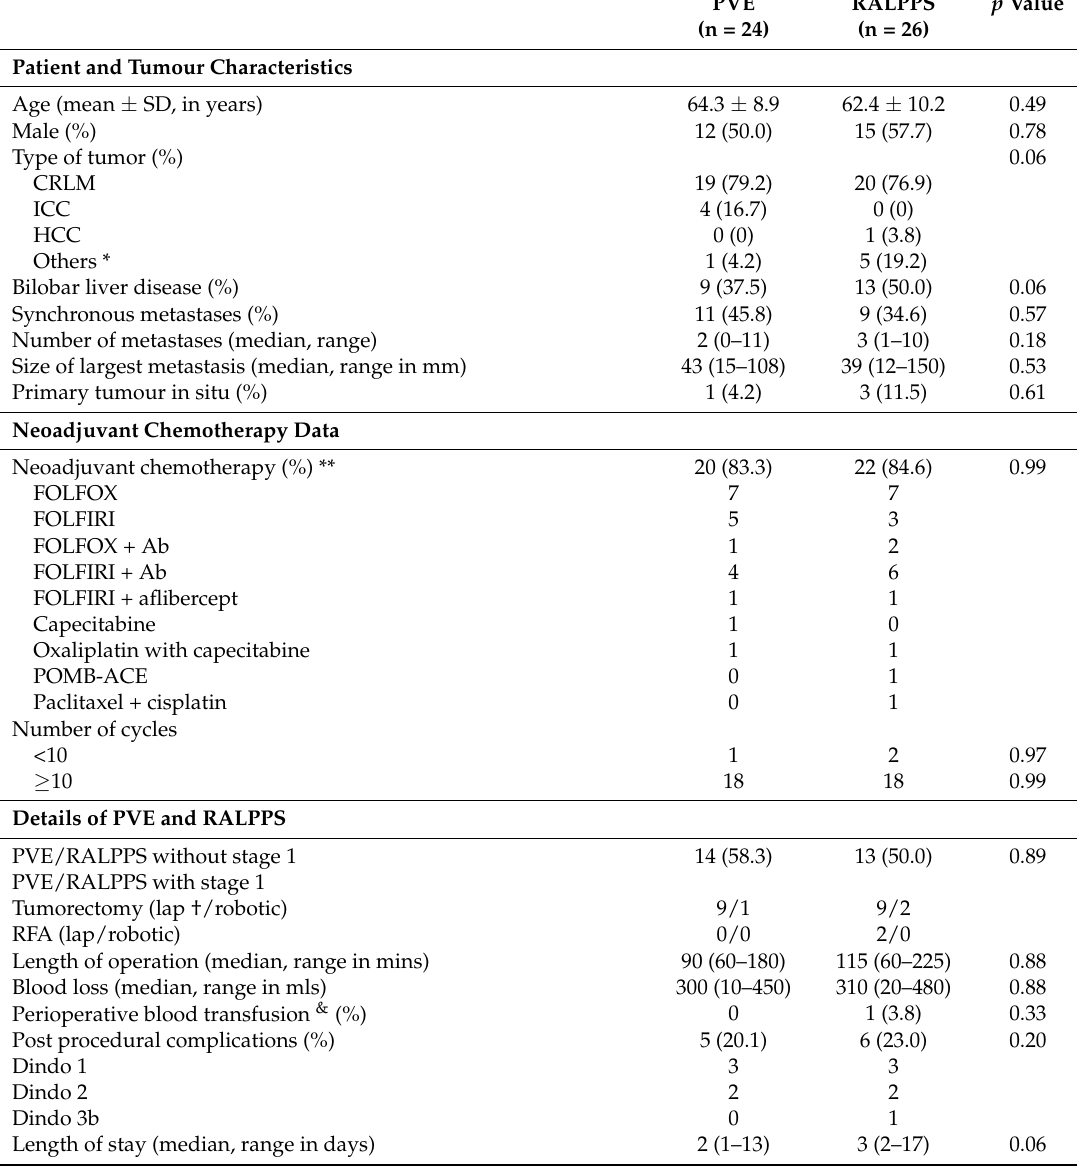
Table 2. Demographic characteristics and outcomes of